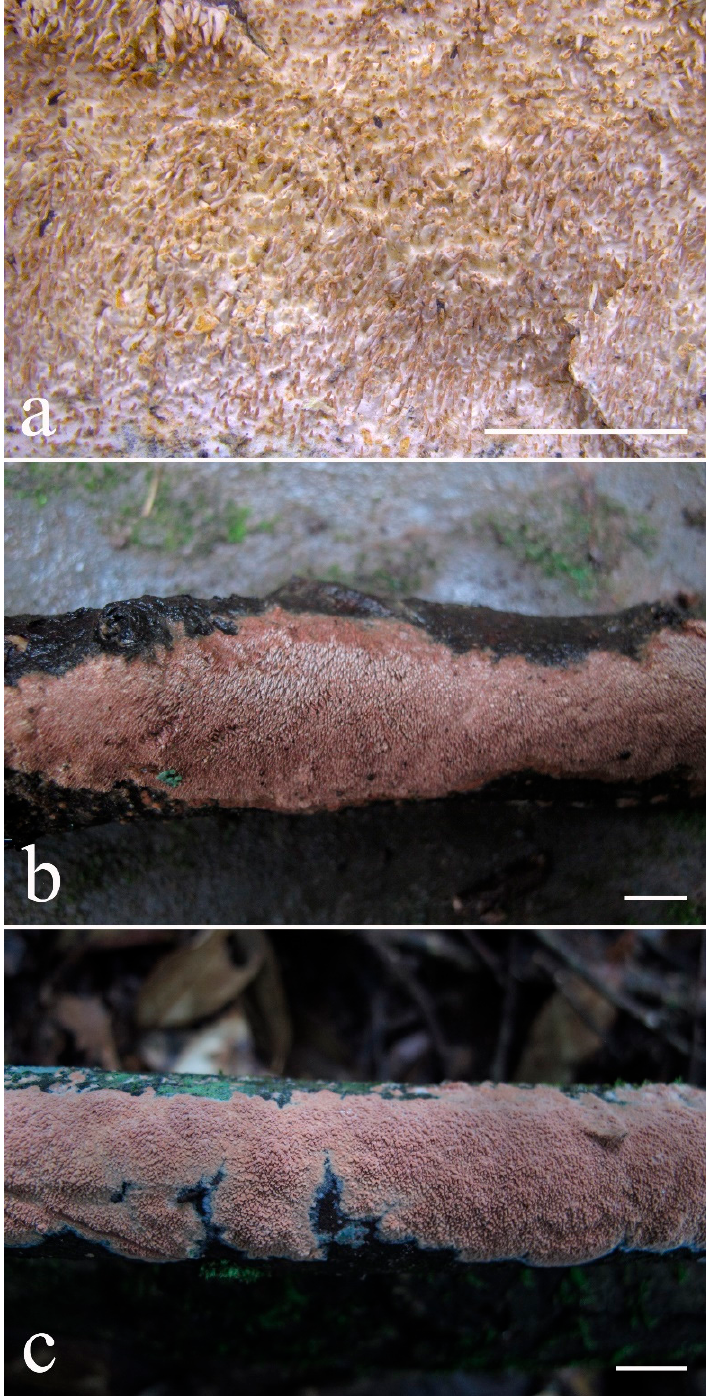
Figure 36. ( a ) Basidiocarps of Xylodon yunnanensis ; ( b ) LWZ 20180920-12a (holotype); ( c ) LWZ 20180922-47 (paratype).— Scale bars: a = 5 mm; b = 2 cm; c = 1 cm.